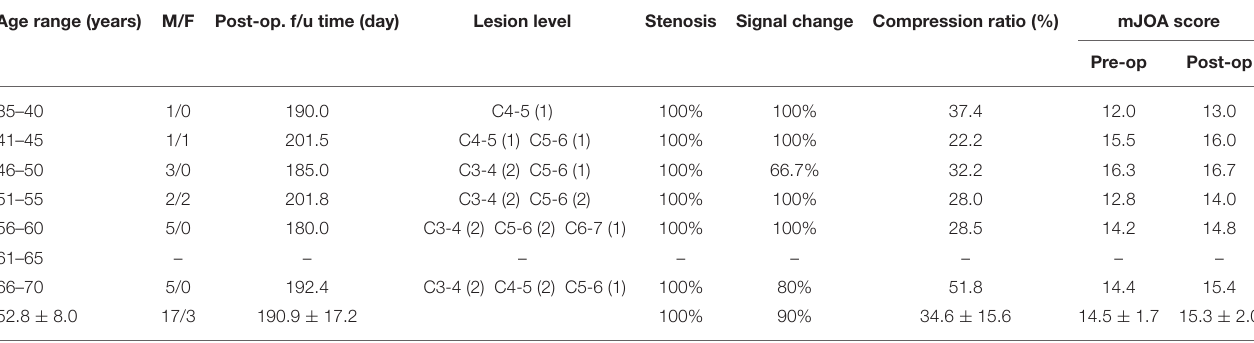
TABLE 1 | Baseline characteristics of the CM